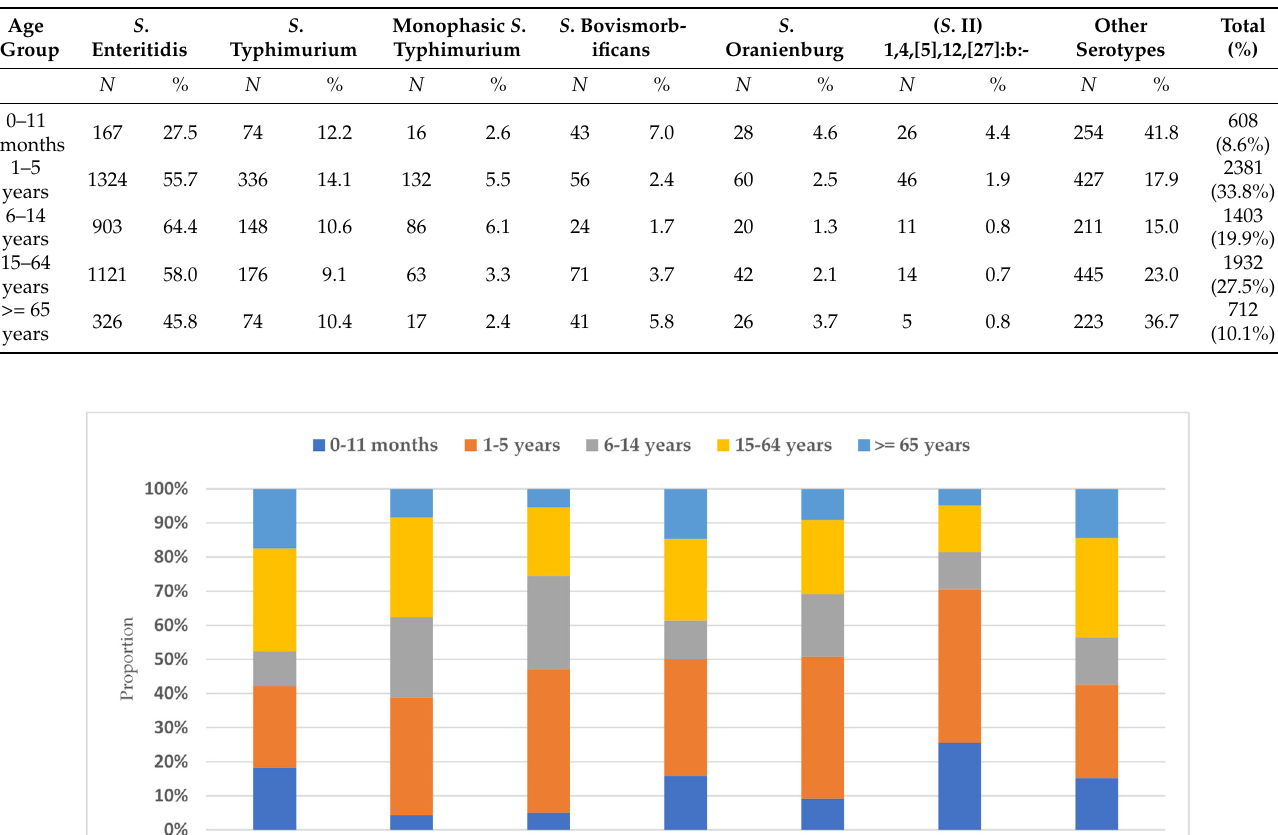
Table 2. Distribution of the Salmonella spp. serotypes by age groups of the persons whose specimens yielded isolates, 2003–2020, Greece ( N = number, % = percentage).